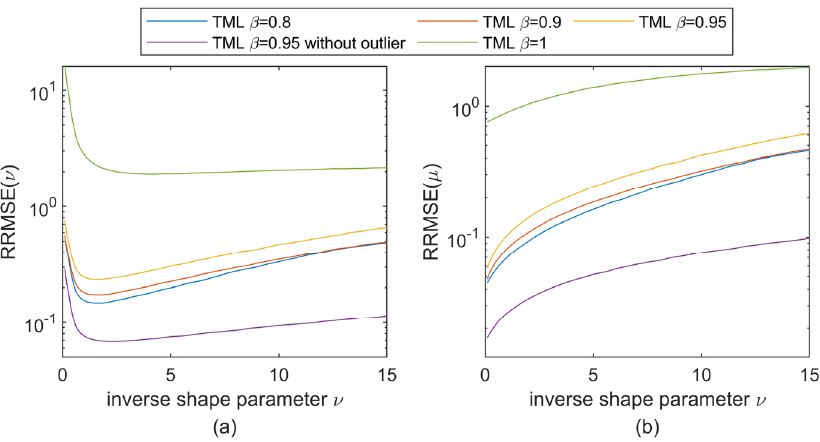
Figure 6. RRMSE comparison of the TML estimators with different truncation ratios: ( a ) RRMSEs of the inverse shape parameter and ( b ) RRMSEs of the scale parameter.